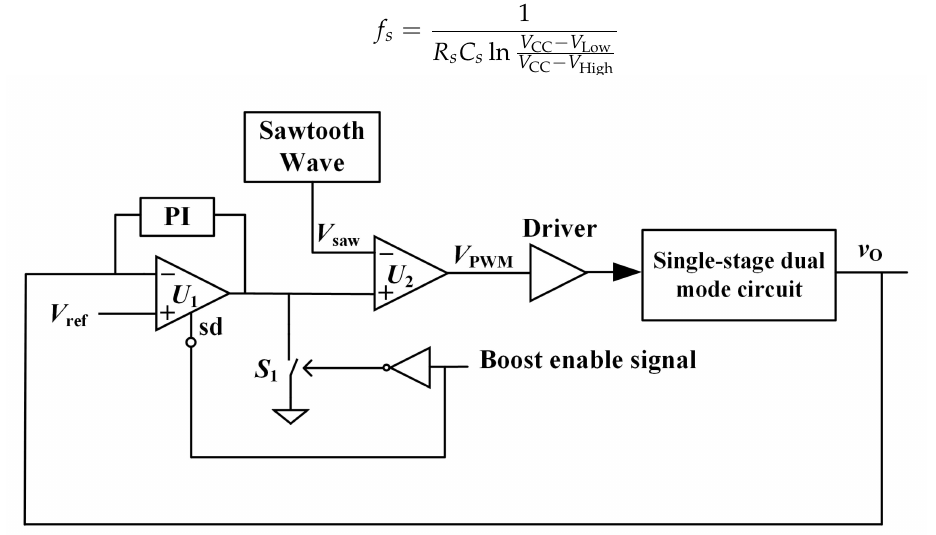
Figure 8. PI-regulated boost mode operation.